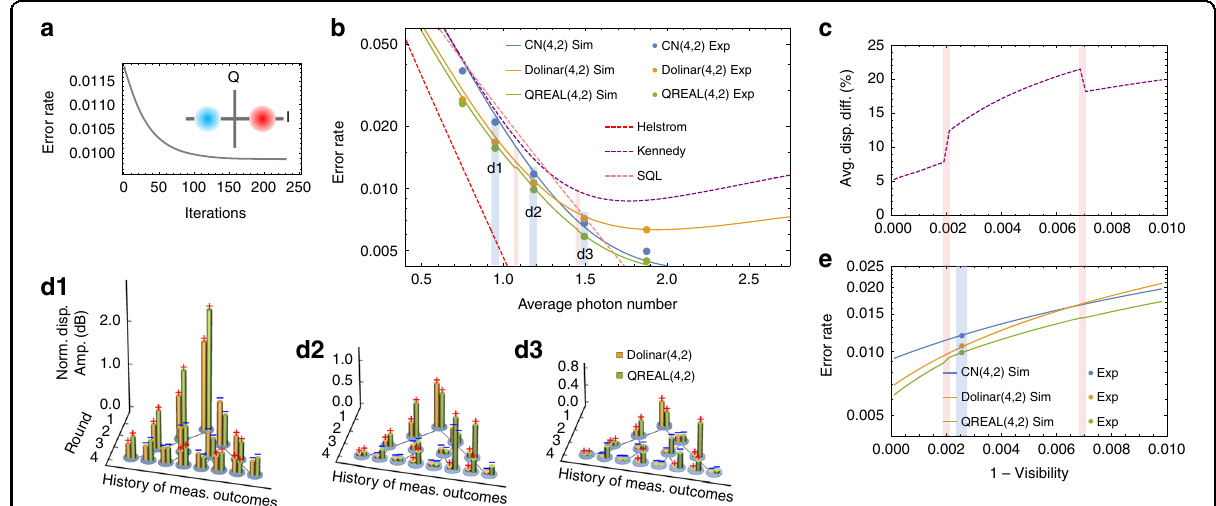
Fig. 2 QREAL for BPSK-encoded quantum-state discrimination. a Evolution of error rate during learning iterations. Inset: constellation diagram of BPSK encoding. b Error-rate comparison for the QREAL and other receivers in the presence of noise. An interference visibility of 99.75% is set in simulations (solid lines) and is measured in experiments (points) for all tested receivers. The Helstrom bound and SQL (homodyne) are noise-free and loss-free. c Average difference in displacement amplitudes applied by the QREAL and Dolinar receiver at sub-unity visibilities, showing QREAL ’ s ability to adapt to imperfections. The corresponding error rates are displayed in e . Red belts mark discontinuities in quantum-receiver strategies, a sign of escaping local optimums. d1 – d3 , show the displacement amplitudes (pillars) and phases (signs) of each node in the Dolinar(4,2) and QREAL(4,2) decision trees at the three different input photon numbers (blue belts in b ). The displacement amplitudes are in a dB scale, normalized to these used in the CN receiver. Mean photon number in producing fi gure a , b , and e is